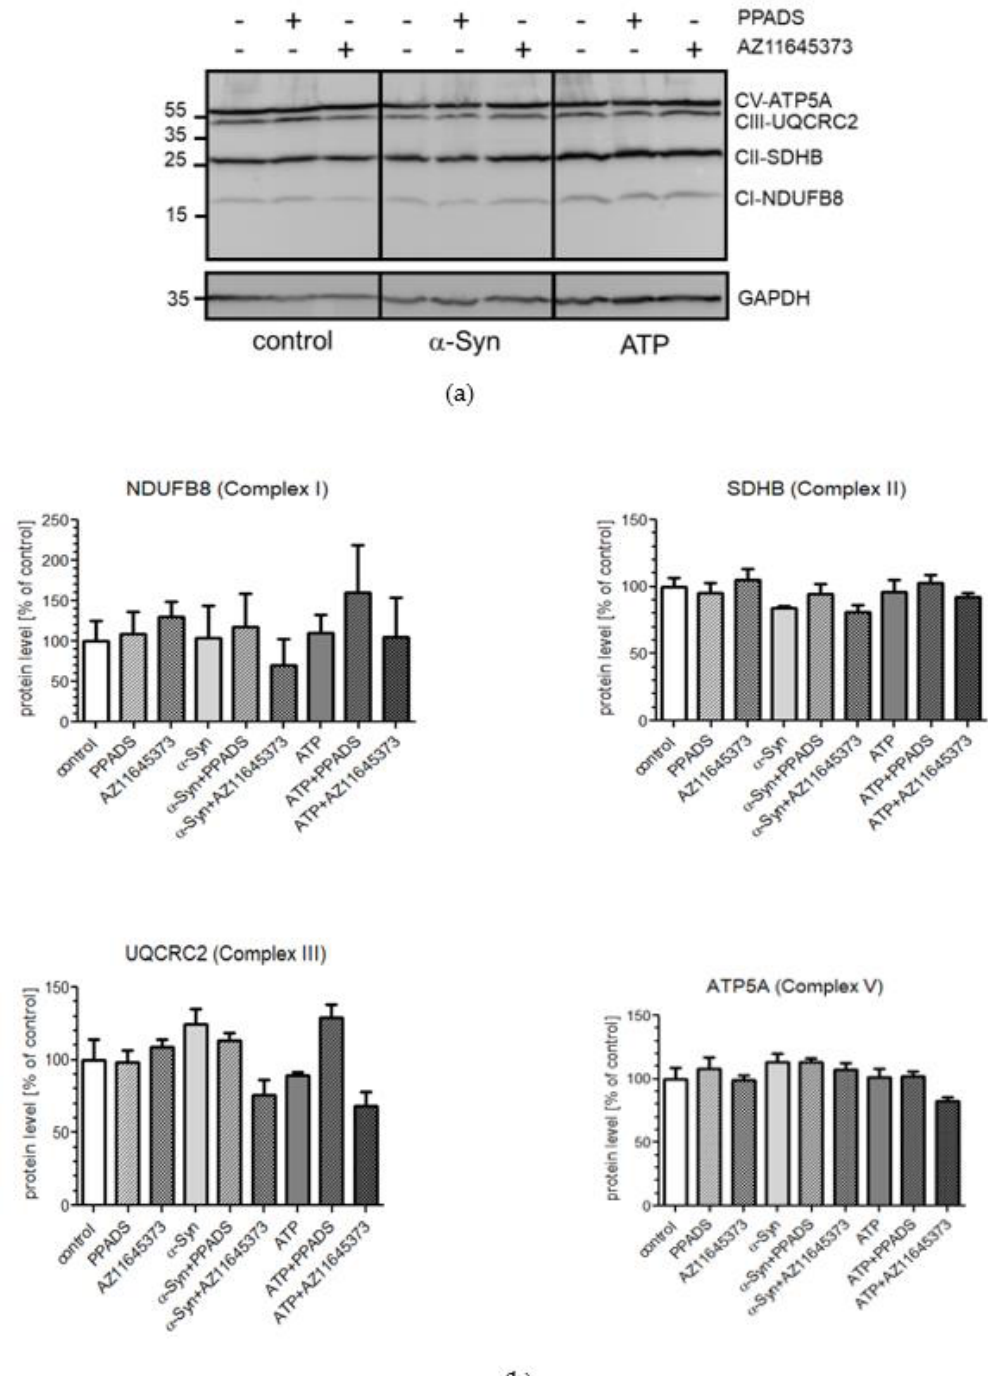
Figure 7. P2X7R activation induced by α -Syn treatment does not change the mitochondrial proteins level. ( a ) SH-SY5Y cells were treated with 10 µ M α -Syn or 1 mM ATP for 24 h in the presence of 100 µ M PPADS or 10 µ M AZ 11645373. Protein levels of representative mitochondrial markers were analysed by Western blotting. GAPDH was used as the loading control. “ + ” with treatment; “-“ without treatment ( b ) Mitochondrial markers immunoreactivity normalized to GAPDH in SH-SY5Y cells. Data were normalized to the untreated control group ( = 100%) and represent the mean value ± S.E.M. for four independent